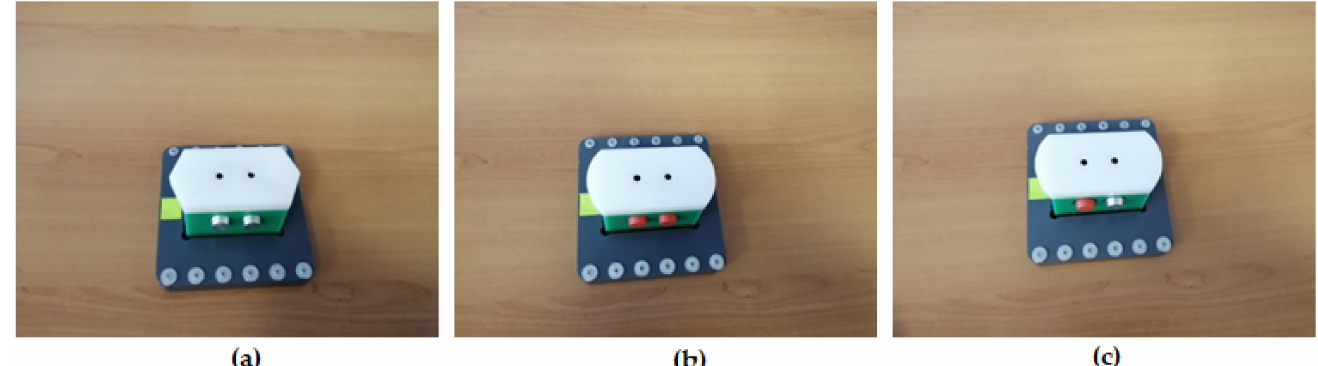
Figure 7. Assembled workpieces: ( a ) workpiece with metal cylinders; ( b ) workpiece with plastic cylinders; ( c ) workpiece with different material